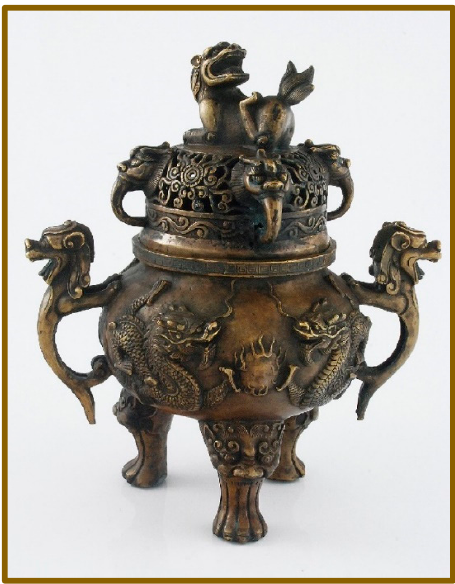
Figure 1. Chinese censer from the turn of the 19th and 20th centuries with three legs to ensure stability.